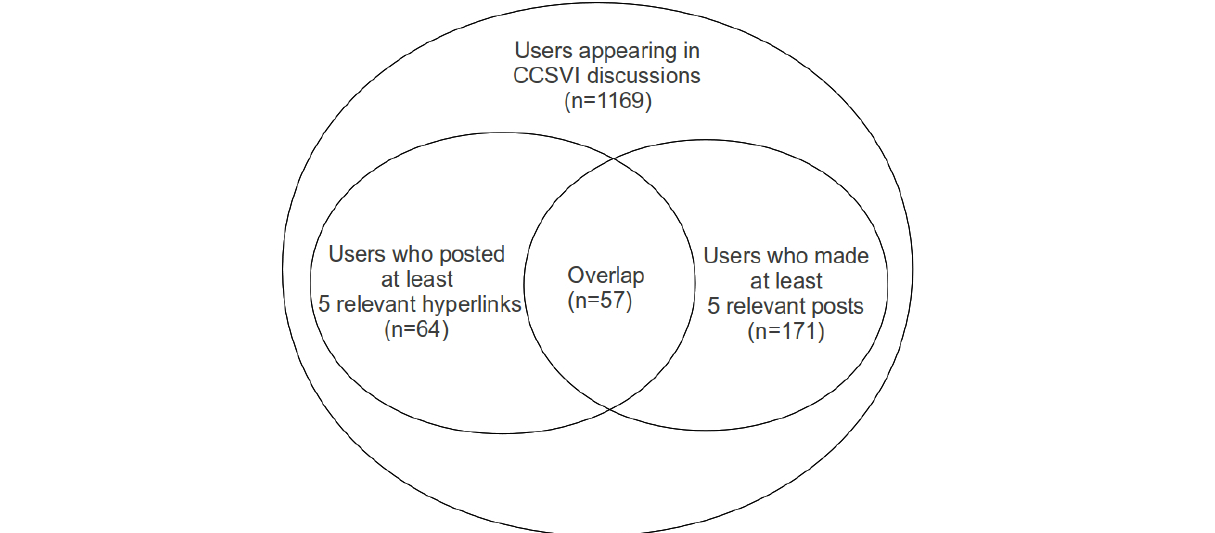
Figure 4. Venn diagram showing the user sets used in the clusterings.